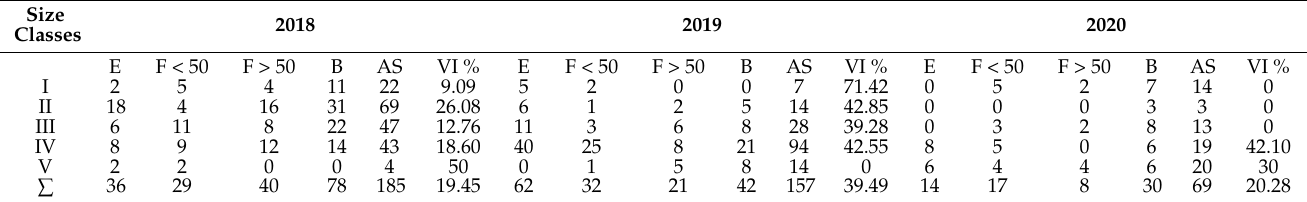
Table 1. Numbers of sampled and analyzed stomachs (AS), with Vacuity Index (VI%) and numbers of Empty (E), Full < 50% (F < 50), Full > 50% (F > 50) and bursting stomachs (B) by ontogenetic classes in the different